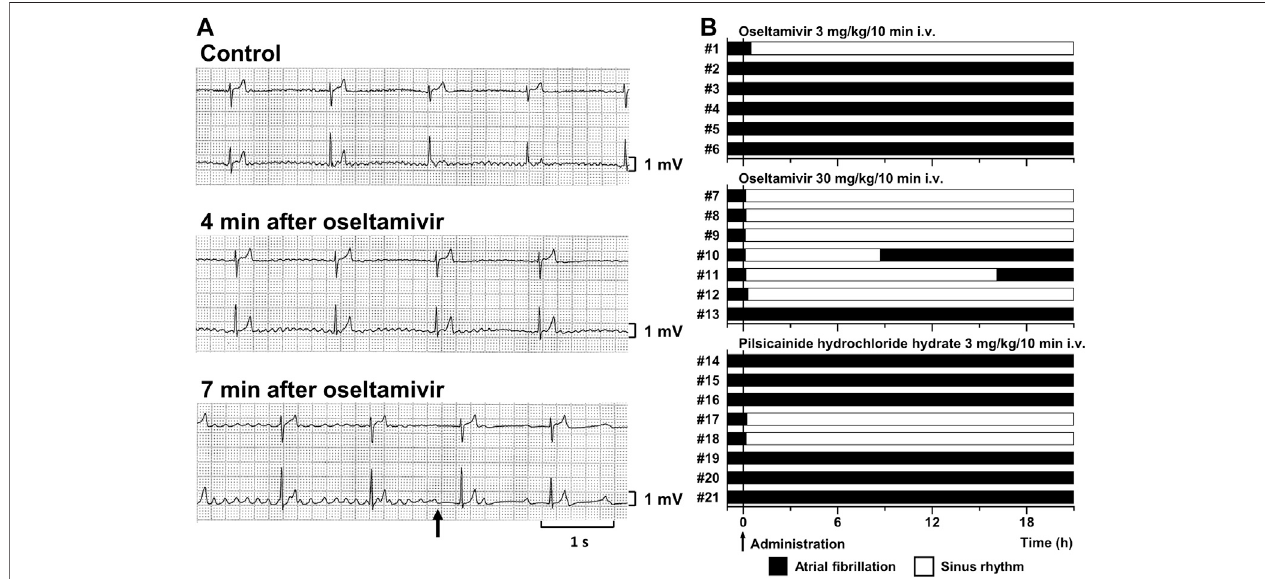
FIGURE 1 | Antiarrhythmic effects of oseltamivir and pilsicainide hydrochloride hydrate on the conscious dogs with persistent AF. (A) Typical tracings of Holter electrocardiogram (NASA lead: upper ; and CM5 lead: lower ) before (Control; top ), 4 min (4 min after oseltamivir; middle ) and 7 min (7 min after oseltamivir; bottom ) after the start of intravenous administration of 30 mg/kg/10 min of oseltamivir (animal number #9). The AF was terminated at 7 min (arrow). (B) Time courses of the antiarrhythmic effects ofoseltamivir indoses of3( top , n (cid:1) 6) and 30 mg/kg/10 min i.v.( middle , n (cid:1) 7)and pilsicainide hydrochloride hydrate inadose of3 mg/kg/ 10 min i.v. ( bottom , n (cid:1)